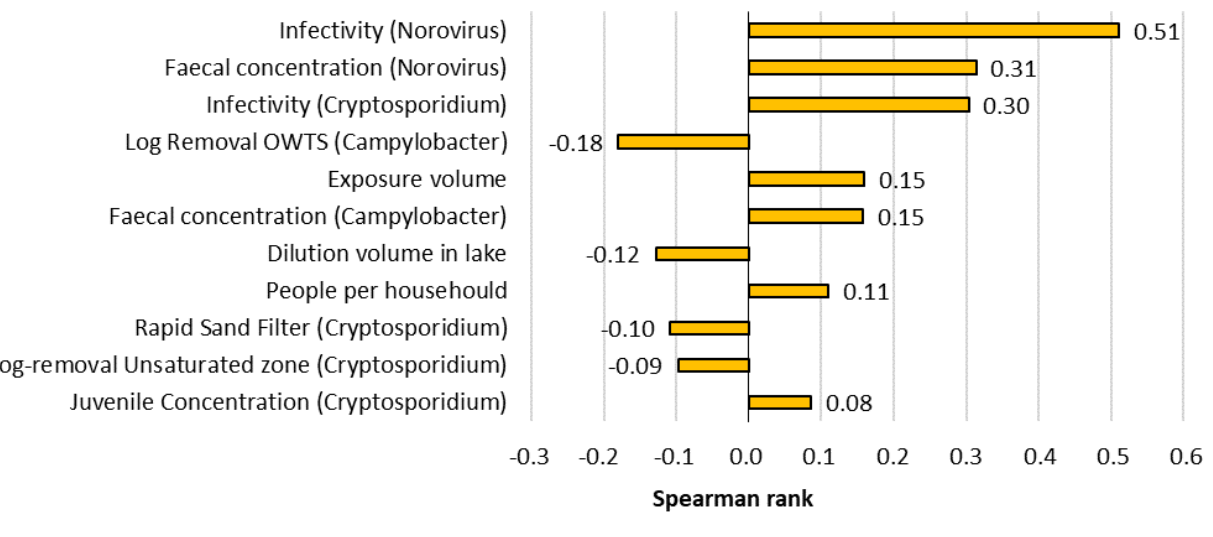
Figure 4. Spearman rank of input variables used in the QMRA.